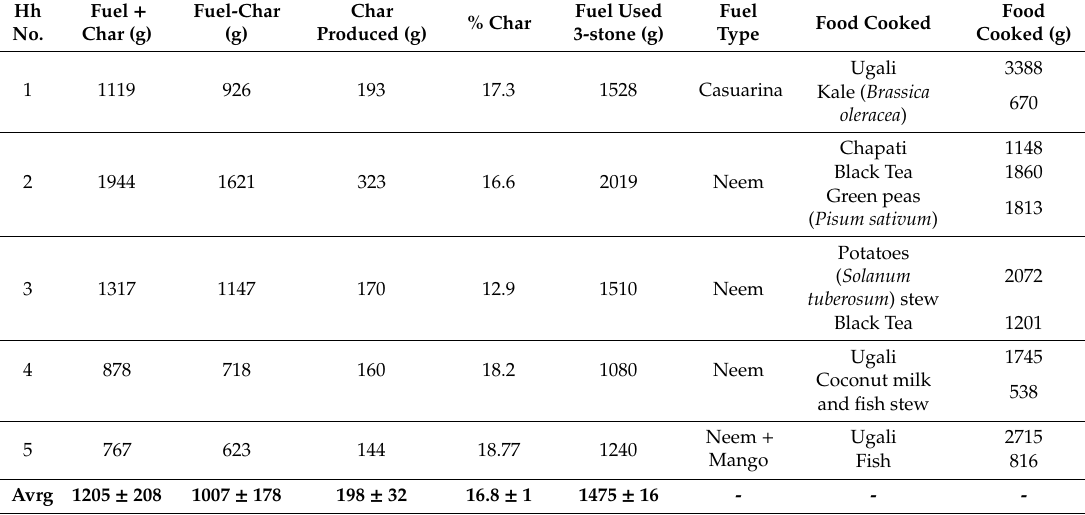
Table 5. Food cooked and fuel used with the gasifier and three-stone (3-stone) open fire. Avrg = Average; Fuel + char = Fuel used during cooking and charring period including char; Fuel-char = Fuel used during cooking and charring period minus